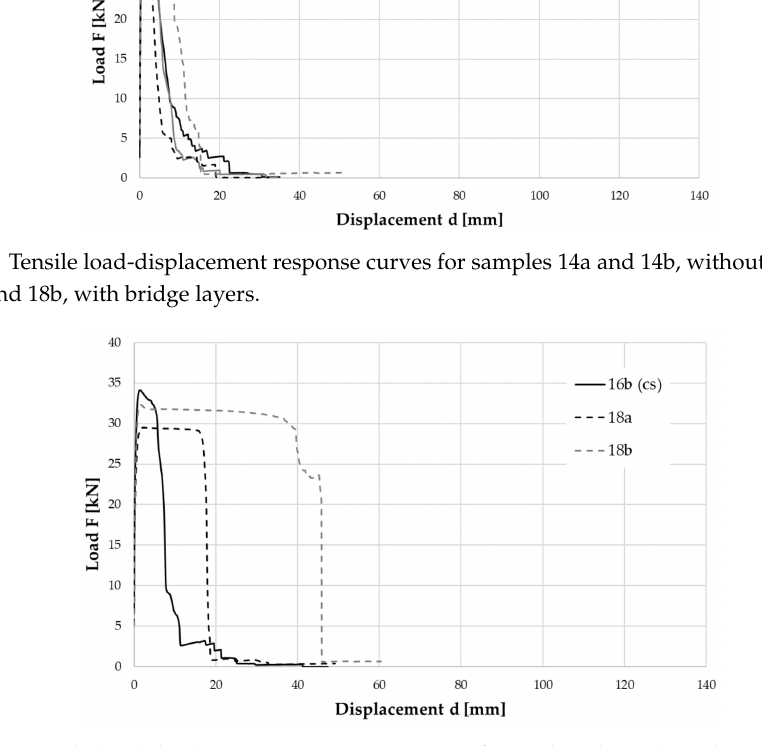
Figure 22. Tensile load-displacement response curves of sample 16b, without bridge layers, and samples 17a and 17b, with bridge